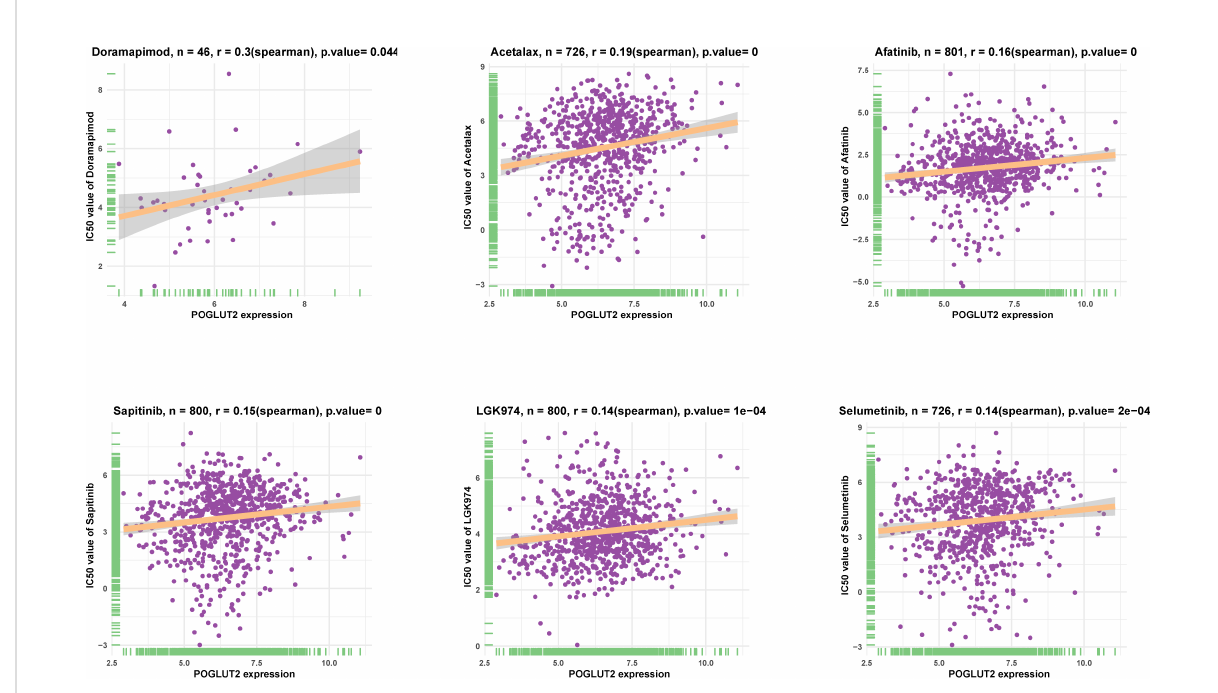
FIGURE 7 The top 6 POGLUT2 positively correlated drugs from GDSC2 database. The association between POGLUT2 and IC50 of 198 drugs was calculated through Spearman ’ s